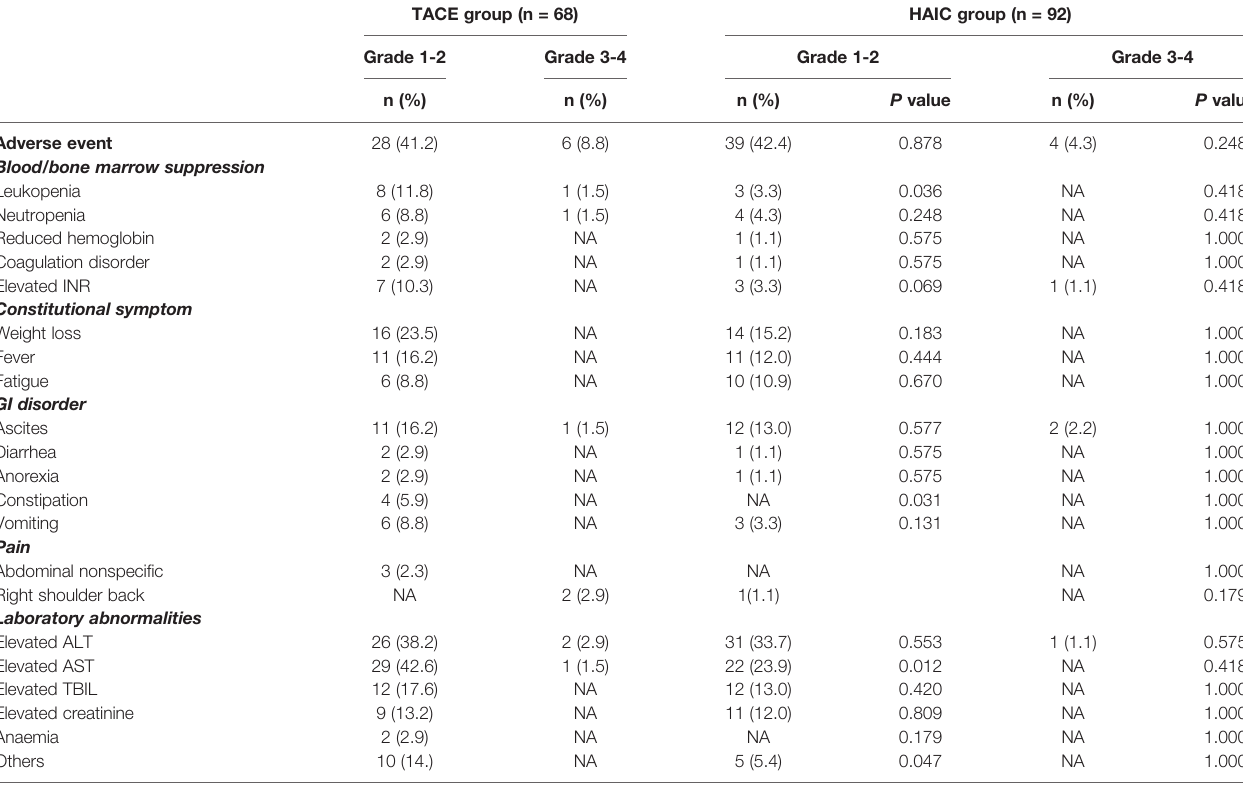
TABLE 3 | Adverse events between TACE group and HAIC